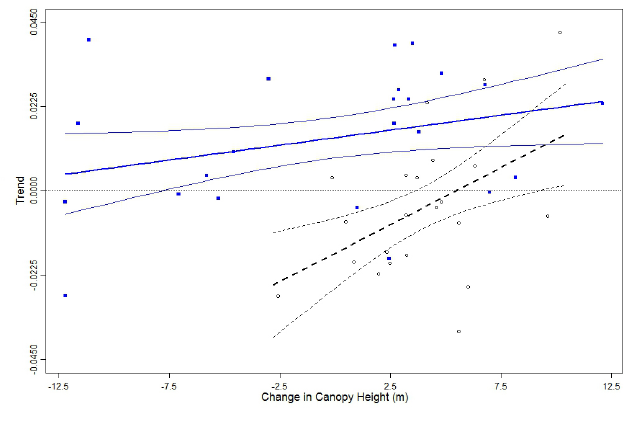
Fig. 8. Increasing trends (with 85% confidence intervals) in abundance of Magnolia Warbler with increasing stand height in disturbed (blue squares and solid line) and undisturbed (open circles and dashed line) mixedwood stands between circa 1994 and 2014. Stands were considered disturbed if we noted the presence of any disturbance (e.g., fire, forest harvest, or windthrow) in the